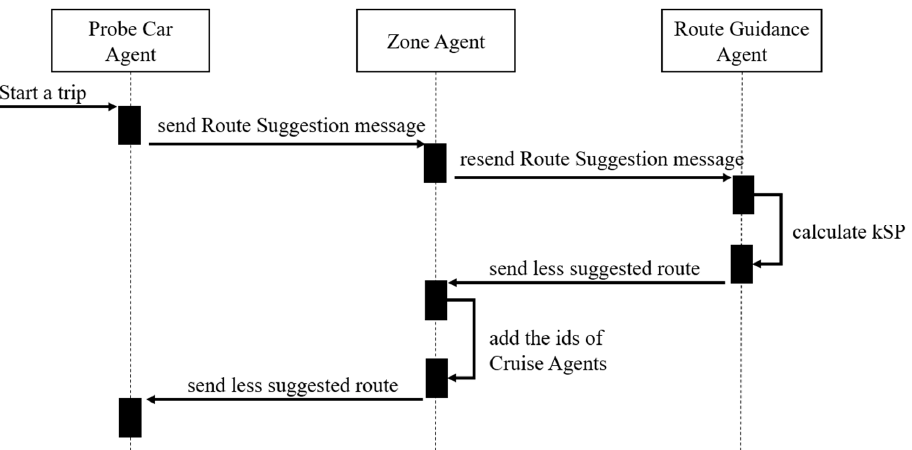
Figure 2. Sequence diagram of a typical initial routing process.